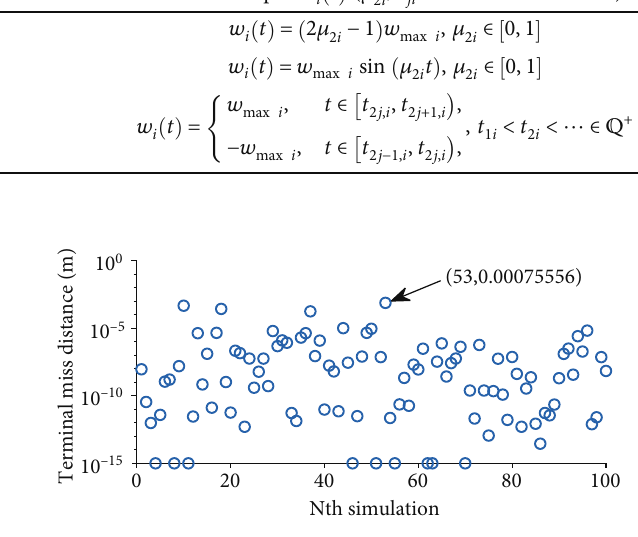
Figure 31: Terminal miss distance of each simulation.